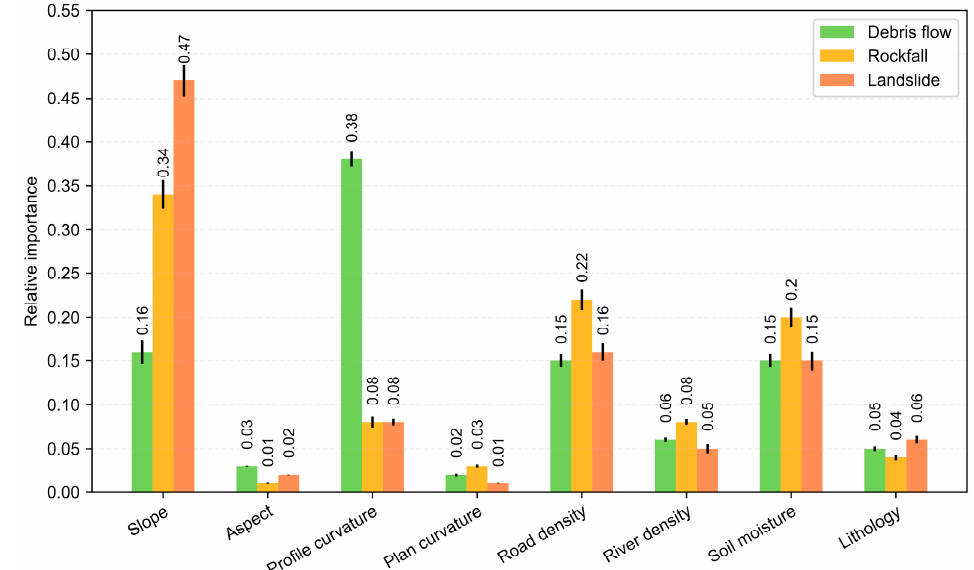
Figure 13. The relative importance of predictors in different mass movements.